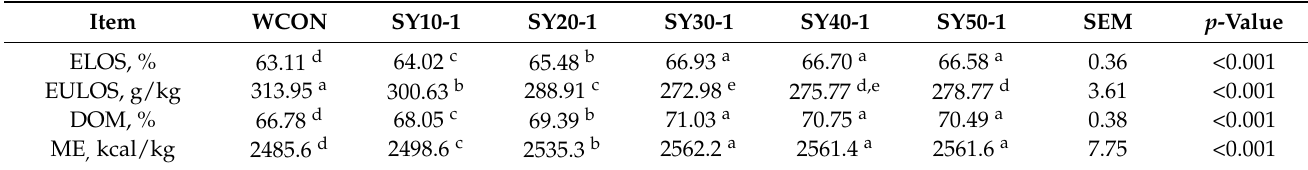
Table 12. In vitro digestibility and ME contents of corn silages (in DM).